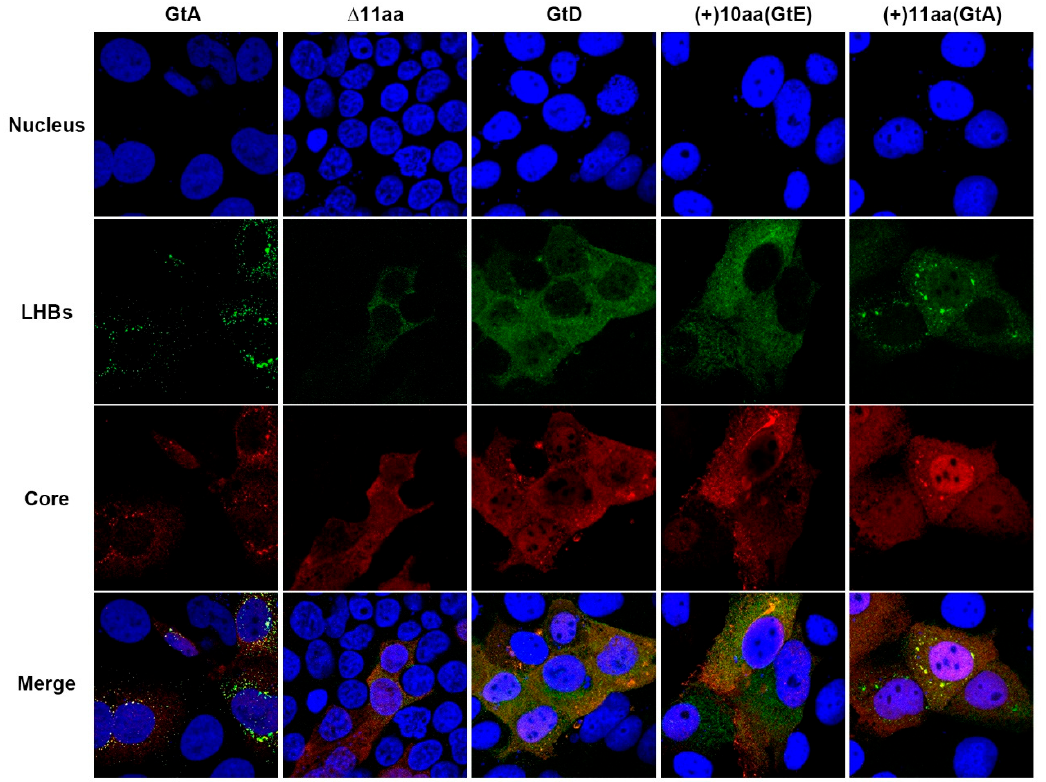
Figure 3. The presence of GtA-derived 11 aa causes significant subcellular accumulation of LHBs. Huh7.5 cells overexpressing genome GtA, GtD and the derivatives were analyzed by confocal laser scanning microscopy (CLSM) using a PreS1-specific monoclonal MA18 / 7 and a core-specific polyclonal antiserum (Dako). Nuclei were stained with DAPI (blue). The merge of the fluorescences were shown in the bottom row. The figures showed a representative result; comparable data were obtained for the analysis of 10 different cells.